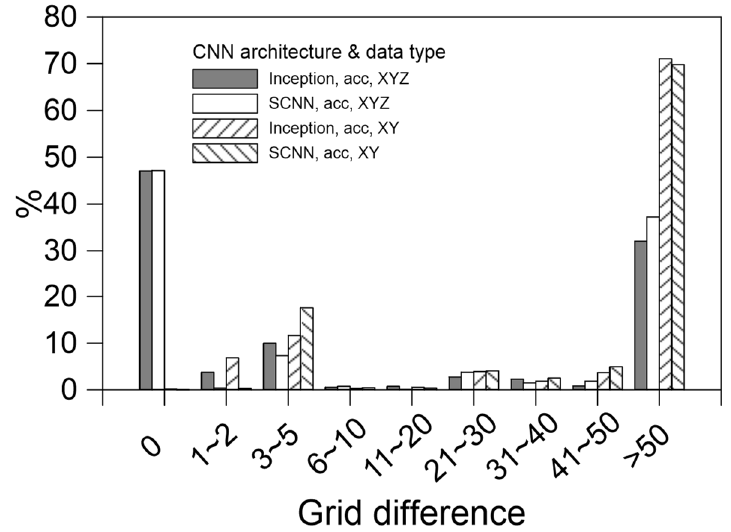
Figure 12. Difference in the location of the maximum flooding depth between the actual data and the predictions made by the artificial intelligence (AI) models.